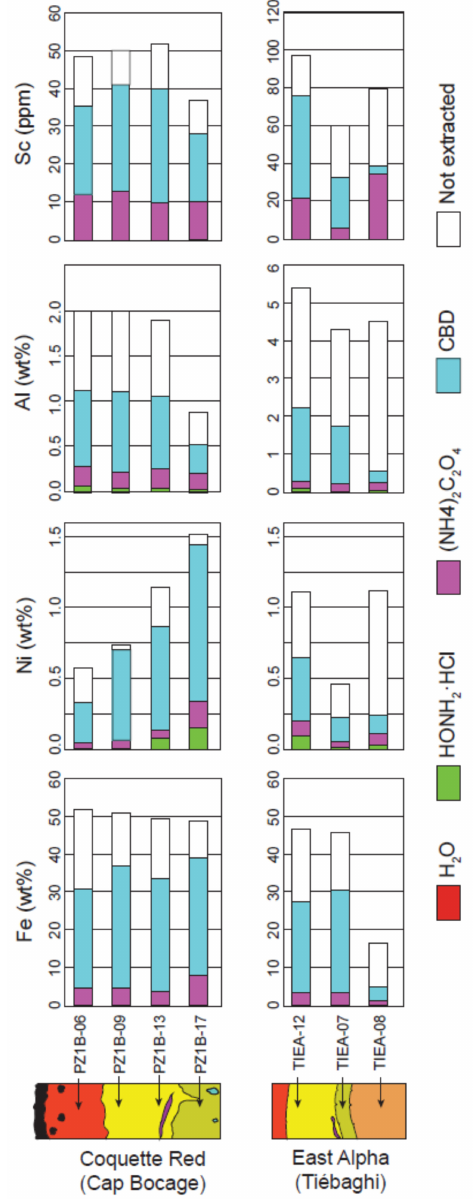
Figure 9. Results of sequential extractions. Cumulative histograms showing the total quantities of Fe (wt%), Ni (wt%), Al (wt%), and Sc (ppm) extracted with the different reagents, as well as the quantities not extracted. H 2 O = Ultrapure water (step 1), HONH 2 -HCl = hydroxylamine hydrochlo- ride 0.1 mol · L − 1 at pH 3.5 (step 2), (NH4) 2 C 2 O 4 = ammonium oxalate 0.2 mol · L − 1 at pH 3 (step 3), CBD = citrate-bicarbonate-dithionite Na 2 S 2 O 4 (22% Na-citrate and 1 g Na-dithionite) (step 4). See Figure 5 for lithology colour